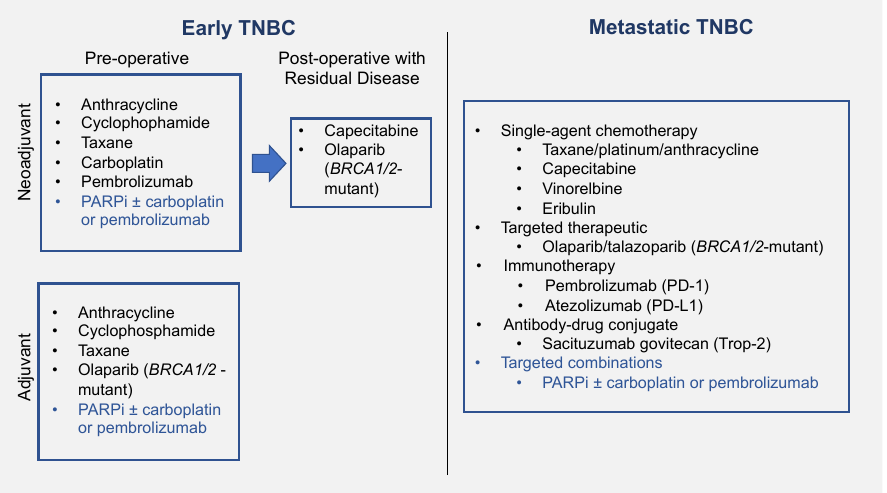
Figure 1. Current and proposed treatment options in TNBC. On the left are treatment options for early breast cancer, and on the right are treatment options for metastatic breast cancer. Current treatment options are in black, and future potential treatment options are in blue. PARPi, PARP inhibitors.